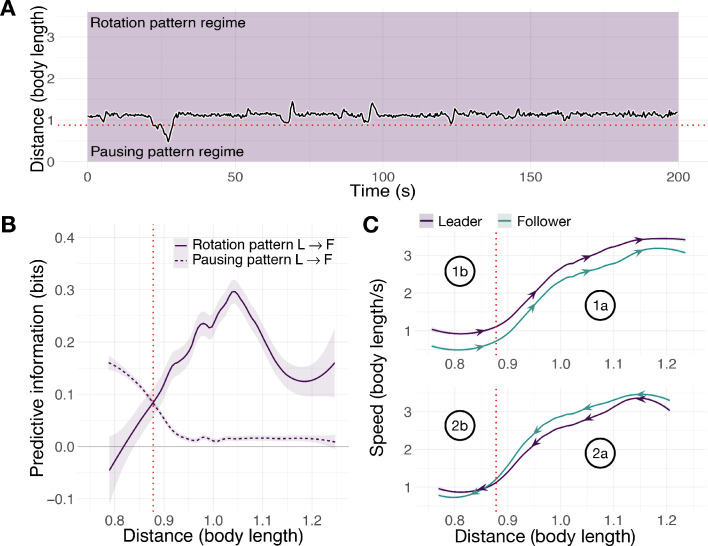
Spatiotemporal dynamics of the termite R. speratus.(A) Distance between the centroids of runners as a function of time. (B) Average predictive information (measured with local transfer entropy) as a function of the distance between centroids of runners (smoothed conditional means with LOESS smoothing and 0.3 span). (C) Average speed of leader and follower as a function of the distance between their centroids for increasing and decreasing distance. Purple represents the leader, green represents the follower.